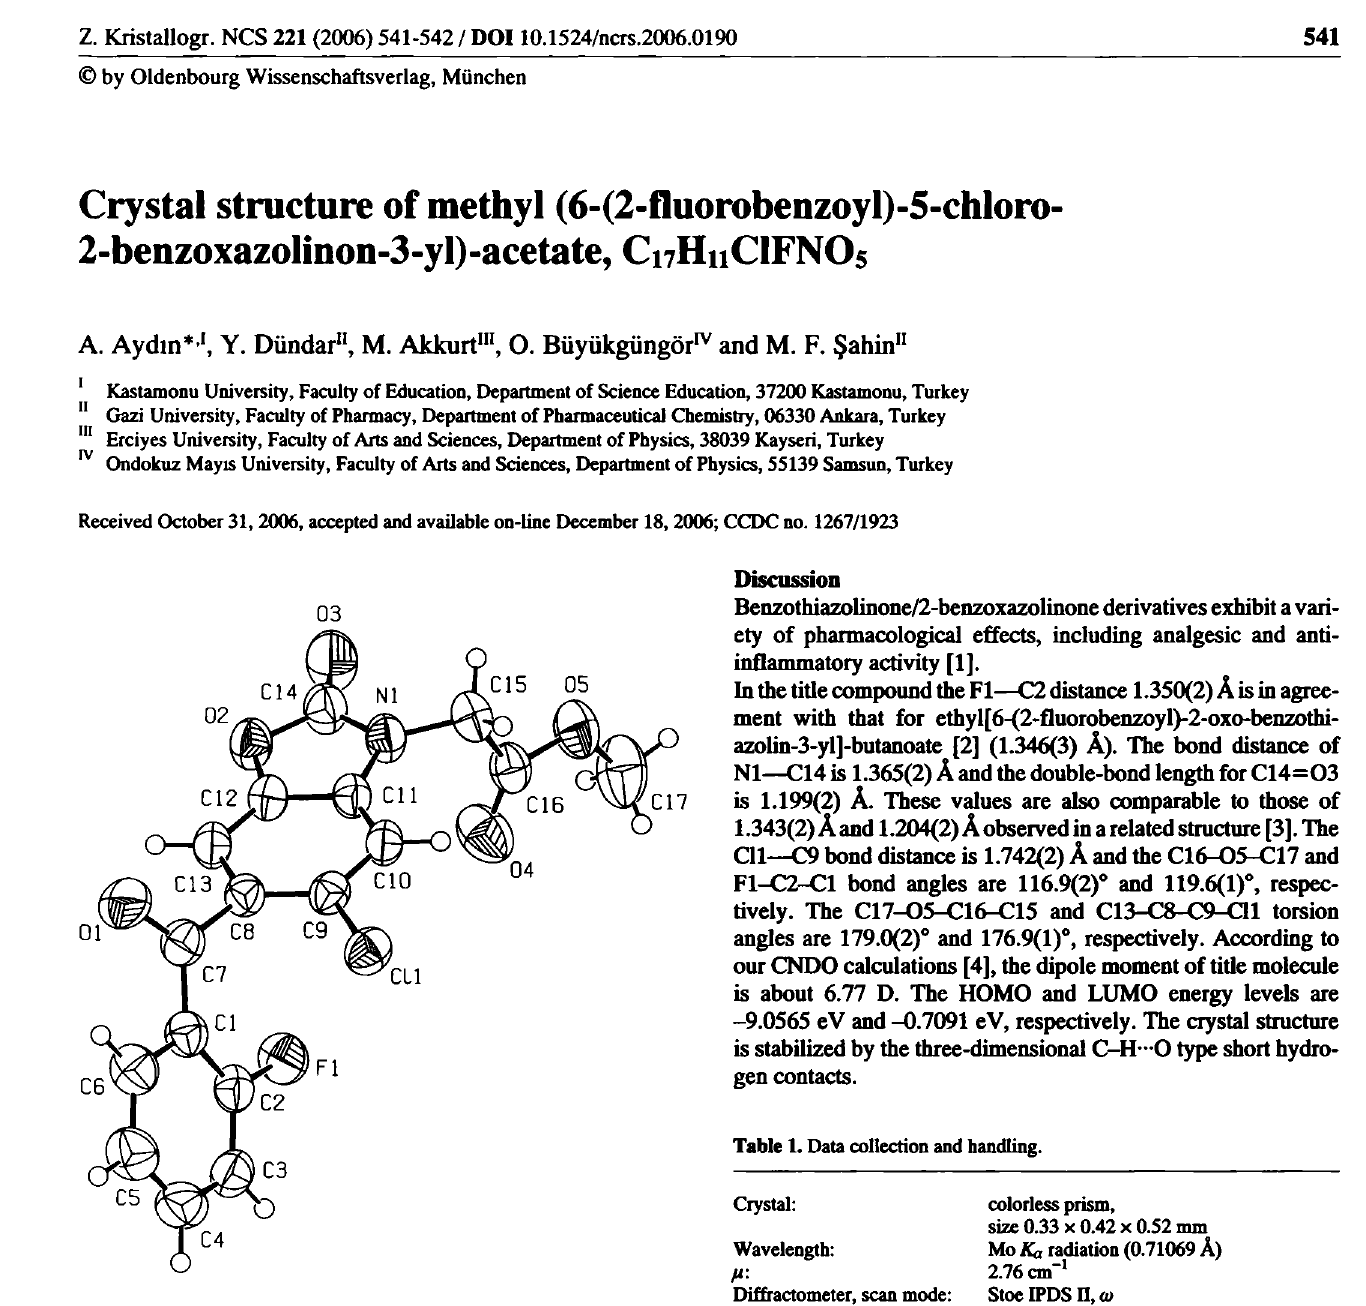
Table 1. Data collection and handling.